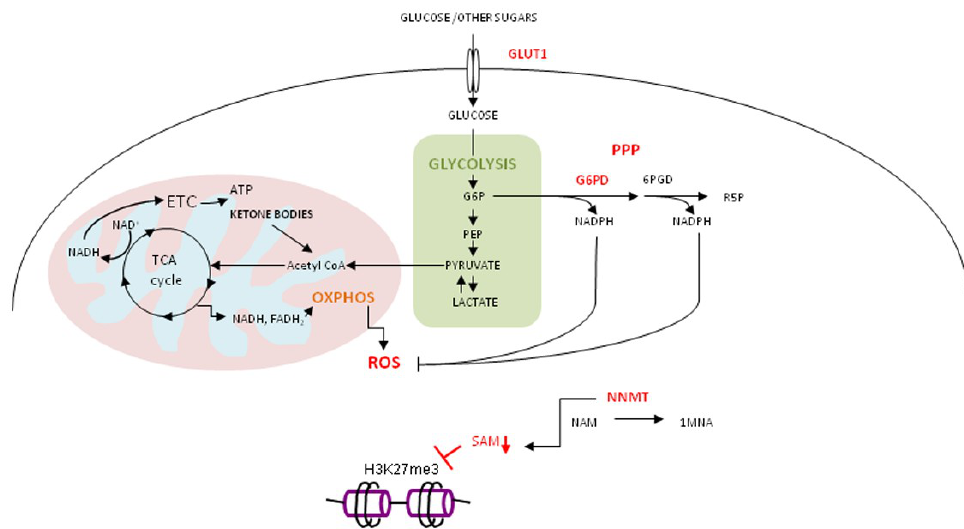
Figure 1. Derailed metabolism of cancer stem cell resistant to glucose deprivation. Metabolically plastic cancer cell, resistant to glucose deprivation, with high expression of GLUT1, G6PDH, G6PD and NNMT, reprograms metabolism to efficiently produce energy through utilization of sugars other than glucose ( D -fructose, D -arabinose, mannan, maltotriose and dextrin), ketone bodies and lactate in OXPHOS. To counteract high level of ROS due to high OXPHOS, PPP is highly active. The upregulation of NNMT consumes methyl groups from S-adenosyl methionine (SAM) for methylation of nicotinamide (NAM). The level of SAM drops and hinders cellular methylation potential.